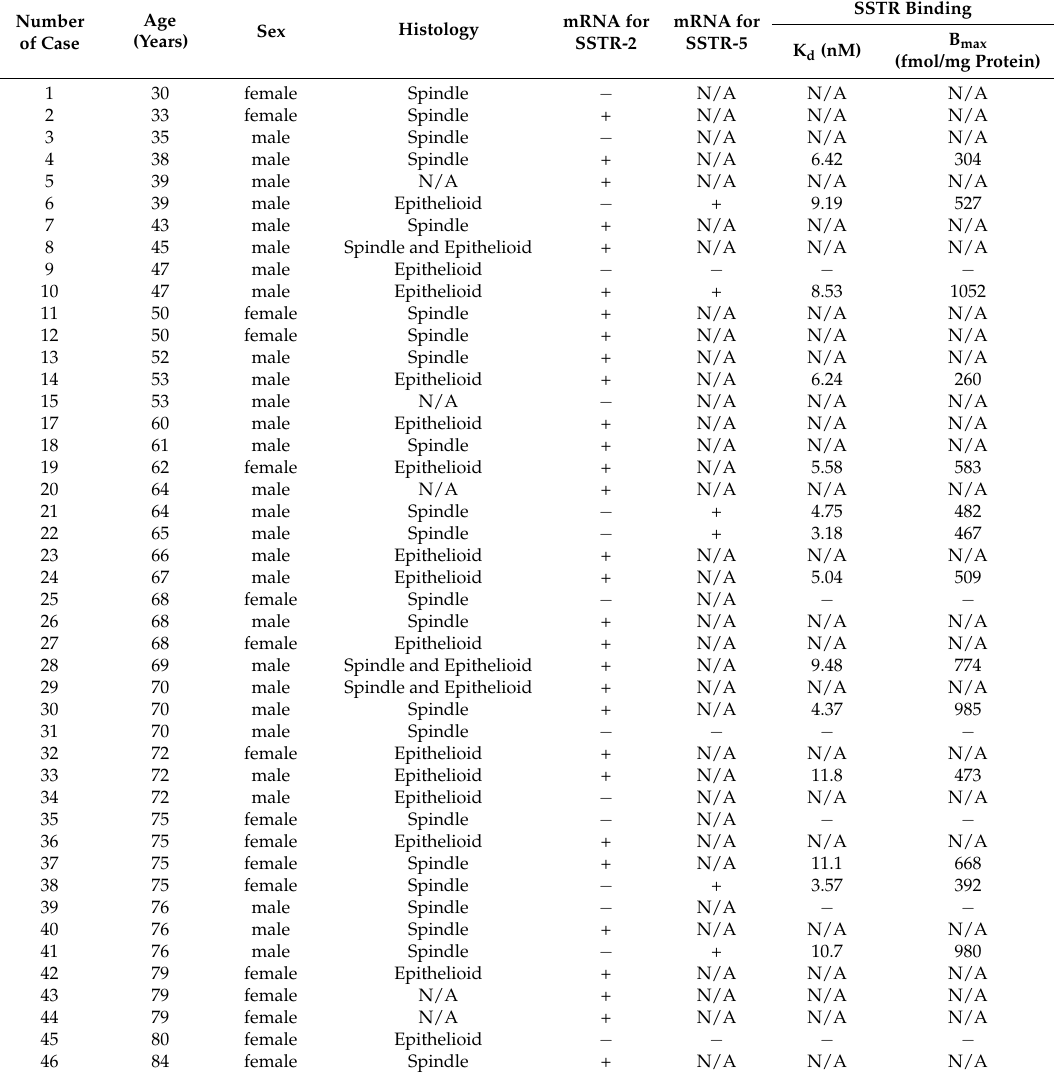
Table 1. Clinicopathological characteristics and SSTR results of uveal melanoma